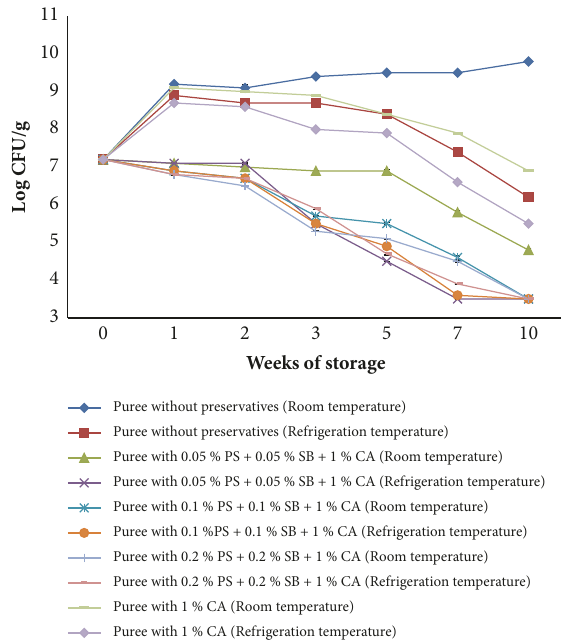
Figure 4: Growth of S. aureus in OFSP puree with preservatives during storage at ambient temperatures (15-25 ∘ C) and refrigeration temperature (4 ∘ C). PS : potassium sorbate, SB : sodium benzoate, and CA : citric